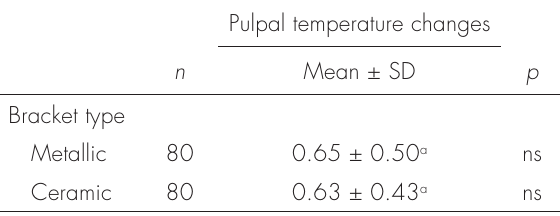
Table IV. Pulpal temperature changes relative to bracket types and statistical